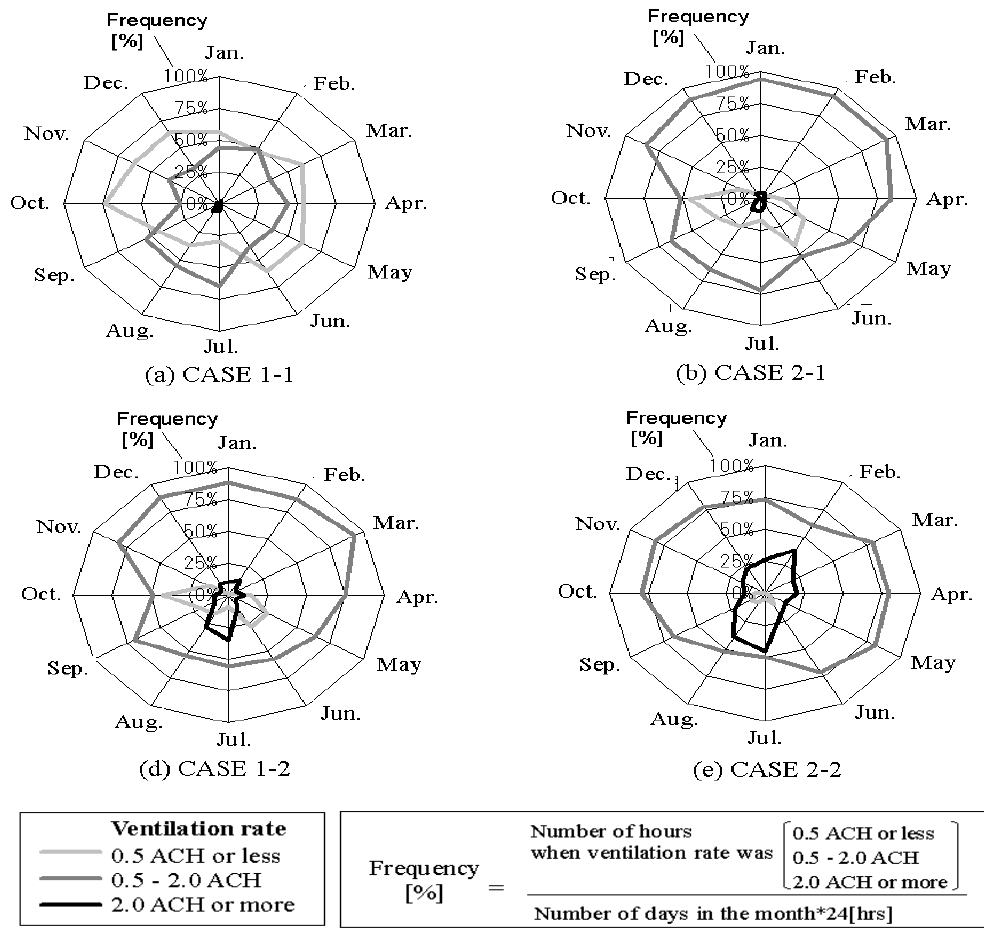
Figure 11. Annual ventilation rate change in a passive house with BAMs.